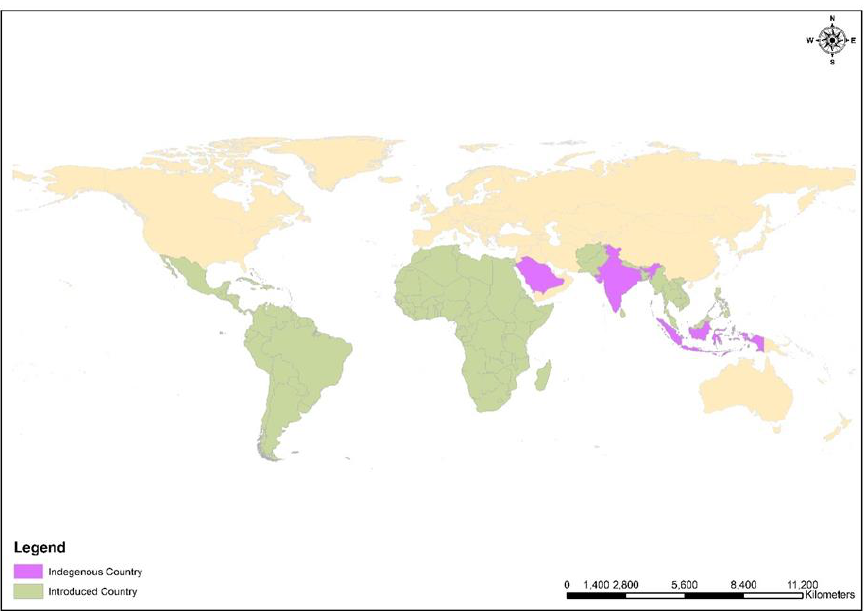
Figure 3. ArcGIS 10.1-based spatial distribution map of Moringa oleifera, the purple color shows the indigenous countries like India, Saudi Arabia, and East indies, whereas the green color shows the introduced countries and regions such as Tropical Asia, Latin America, Africa, Pacific Island, Caribbean Florida, Madagascar, Central America, Cuba, Philippines, Ethiopia, and Nigeria. GIS layers were obtained from DIVA-GIS, an open-source web platform.